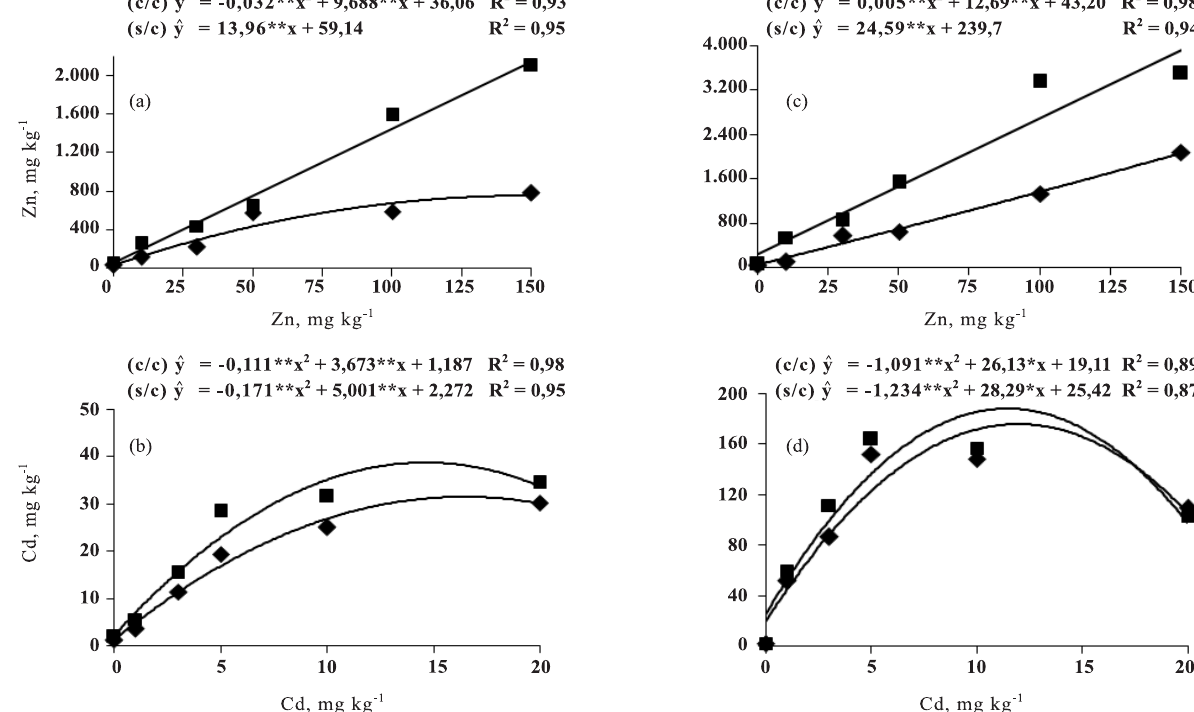
Figura 2. Teores de Zn e Cd na parte aérea (a) e (b) e raiz (c) e (d) de milho submetido a doses crescentes de metais no solo com ( ) e ( ) sem